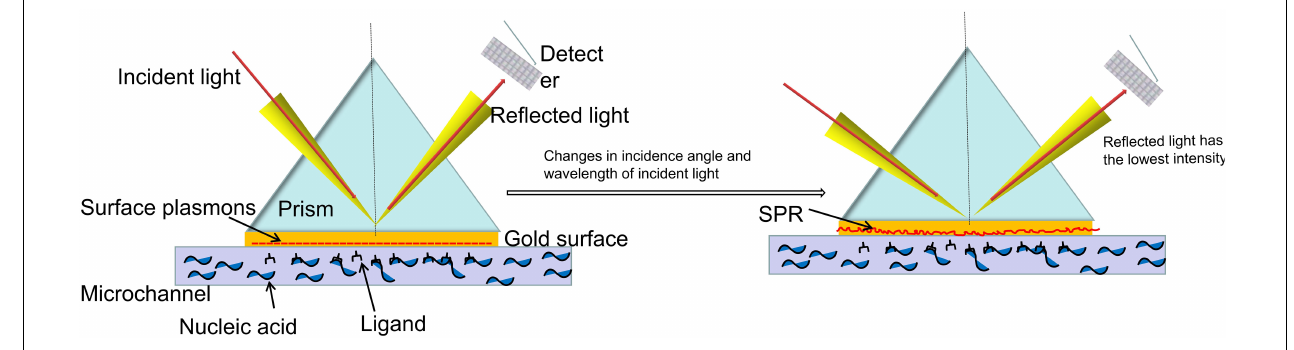
FIGURE 7 | Schematic diagram of surface plasmon resonance.